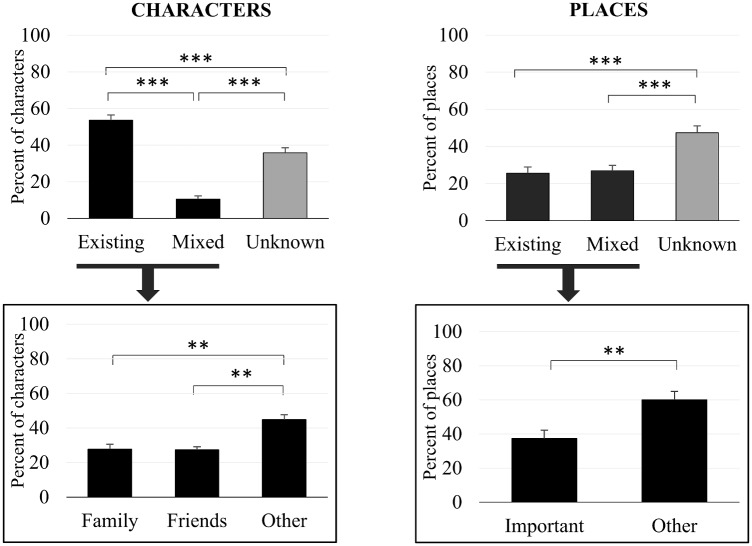
Characters and places of the dreams.Error bars represent standard error of the mean. **p<.01 ***p<.001.